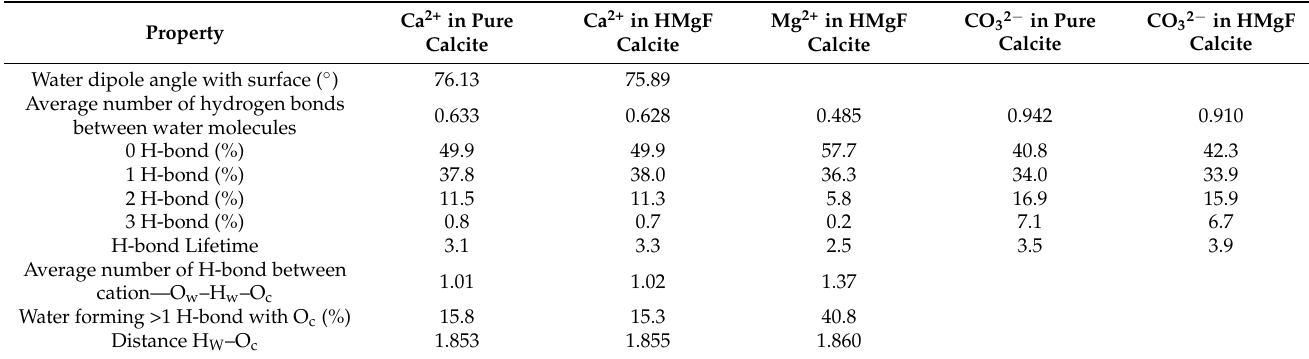
Table 1. Interfacial water dipole angle and H-bond